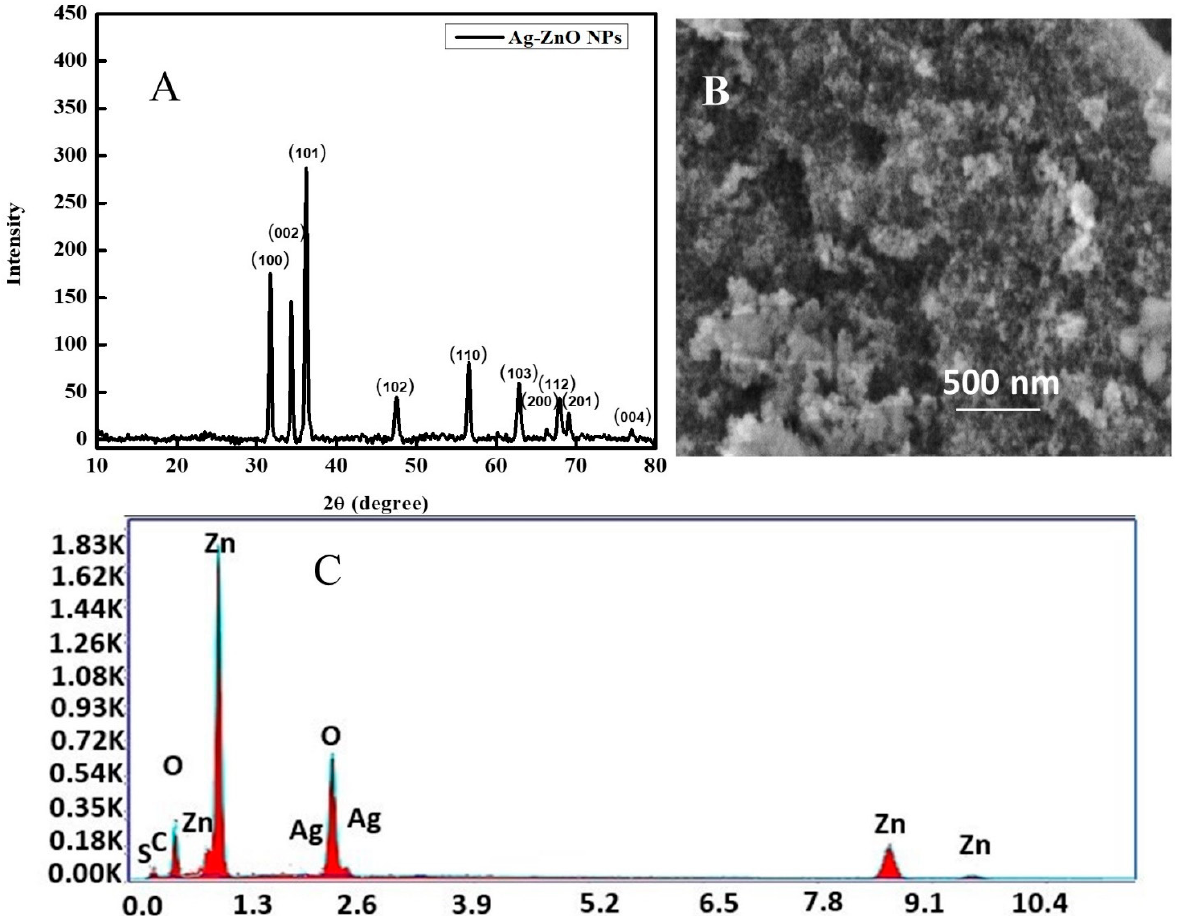
Figure 2. ( A ) X-ray diffractogram of Ag-ZnO, ( B ) SEM micrograph of Ag-ZnO, and ( C ) EDX spectrum of Ag-ZnO nanoparticles.